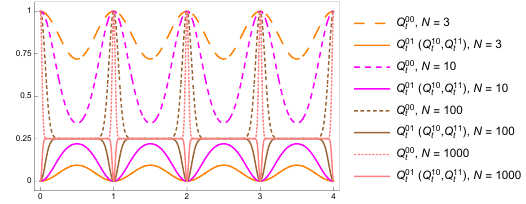
Figure 5. The accumulative total anyon-charge